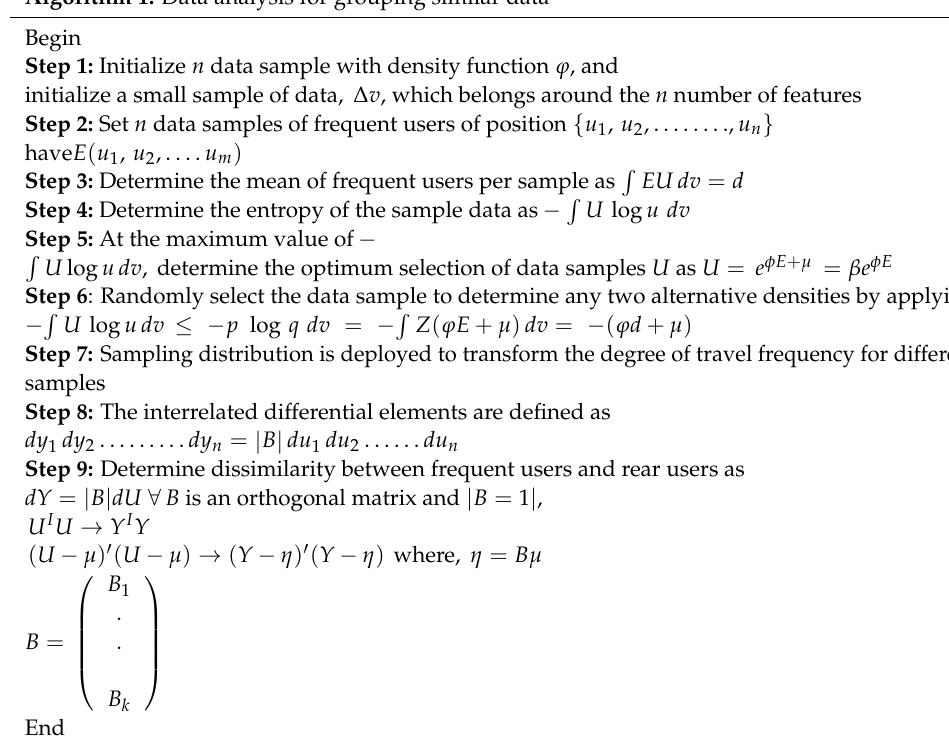
Algorithm 1: Data analysis for grouping similar